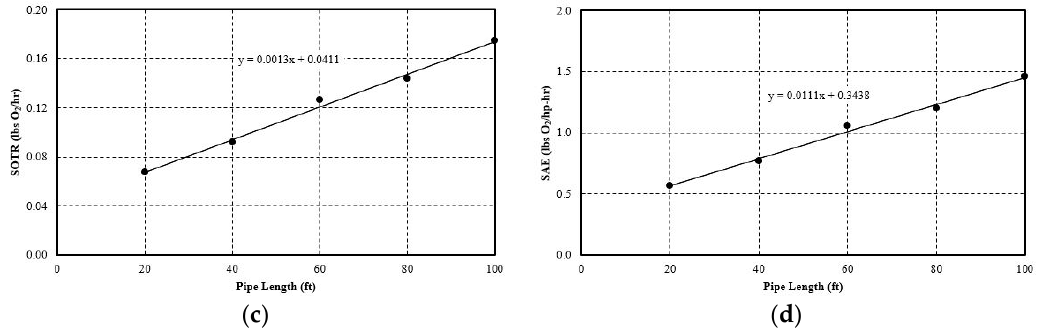
Figure 7. E ff ect of pipe length on: ( a ) Dissolved (mg / L) oxygen vs. time (min); ( b ) K L a (h − 1 ); ( c ) SOTR Figure 7. Effect of pipe length on: ( a ) Dissolved (mg/L) oxygen vs. time (min); ( b ) K L a (h − 1 ); ( c ) SOTR (lbs O 2 / h); ( d ) SAE (lbs O 2 / hp-h). (lbs O 2 /h); ( d ) SAE (lbs O 2 /hp-h).